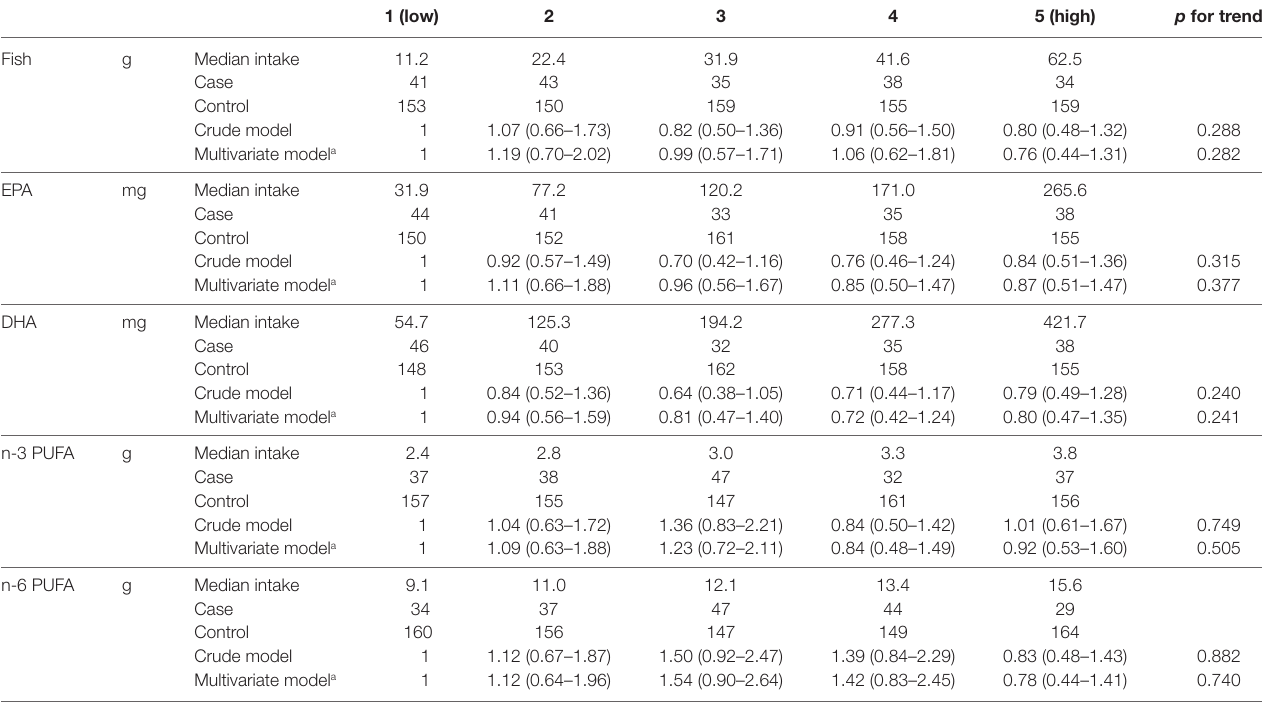
TaBle 3 | Odds ratios [95% confidence interval (CI)] for depression (EPDS score ≥ 9) at 1 month after childbirth according to quintile of fish and PUFA intake in late pregnancy. 1